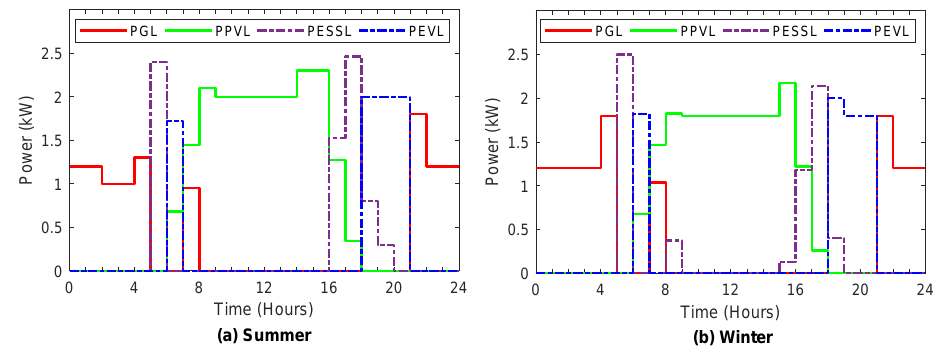
Figure 6. Optimal power scheduling to feed the load demand in summer and winter. Figure 7 displays the optimal power flows from/to the energy storage system during the typical day in winter and summer, which include power from ESS to load and grid and power from PV generation and grid to ESS. The ESS is charged from the grid during off-peak intervals. When the PV generation is sufficient and more than the household load, priority is given to charge the ESS from the PV generation in those periods. The energy stored in the ESS is utilized to minimize the daily cost of electricity and satisfy the demand by discharging the ESS to feed the load during peak periods, and periods when PV generation is insufficient, in addition to selling the energy stored in the ESS to the grid when the electricity prices are high.